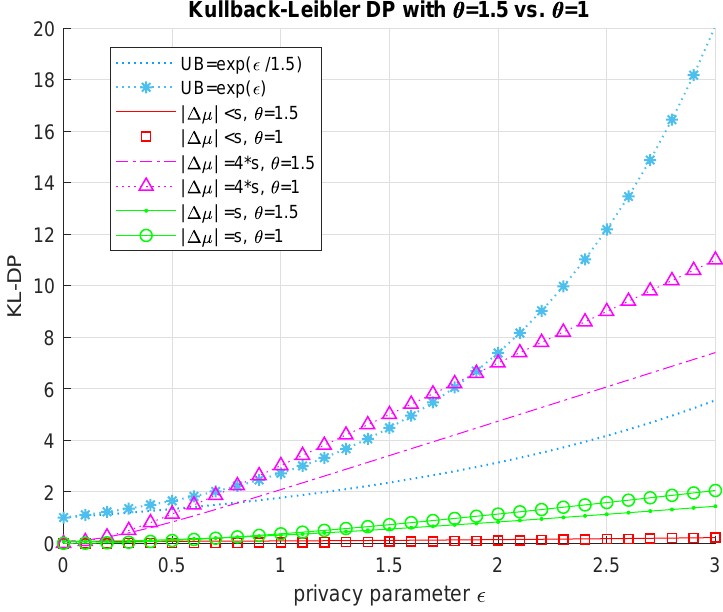
Figure 5. KL-DP for different values of privacy parameter and θ = 1 vs. θ =